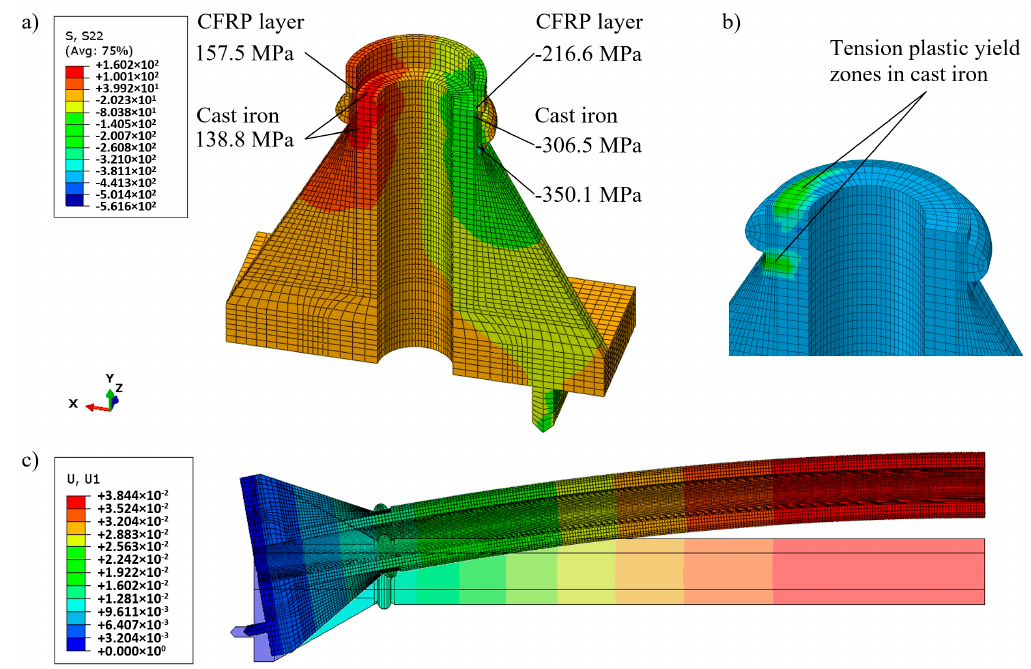
Figure 11. Nonlinear analysis of the strengthened column for N = 207 kN: ( a ) Distribution of the longitudinal stresses; ( b ) plastic yield zones; ( c ) distribution of lateral displacements (mm).